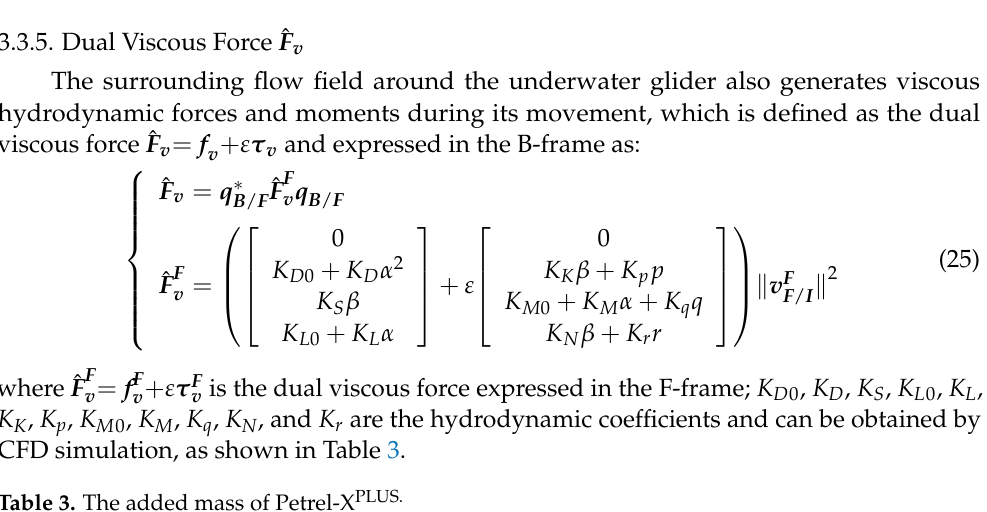
Table 3. The added mass of Petrel-X